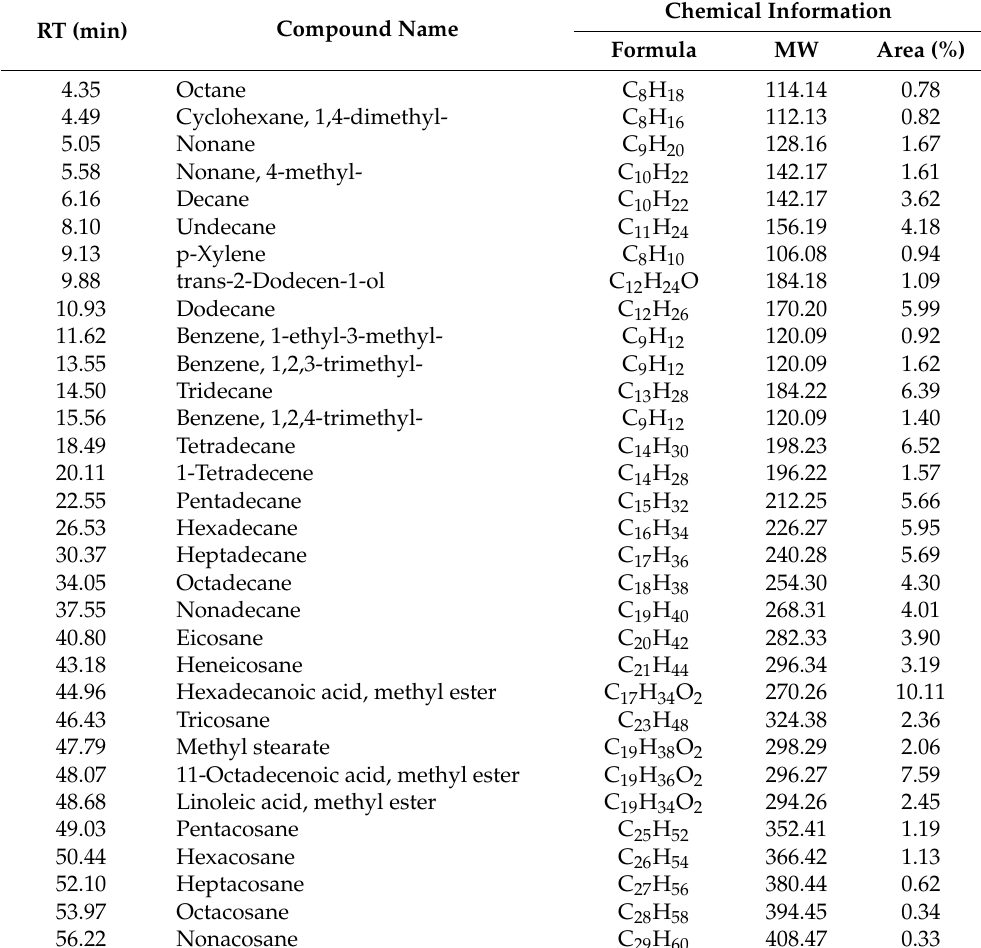
Table 3. The identification and distribution of the compounds for diesel